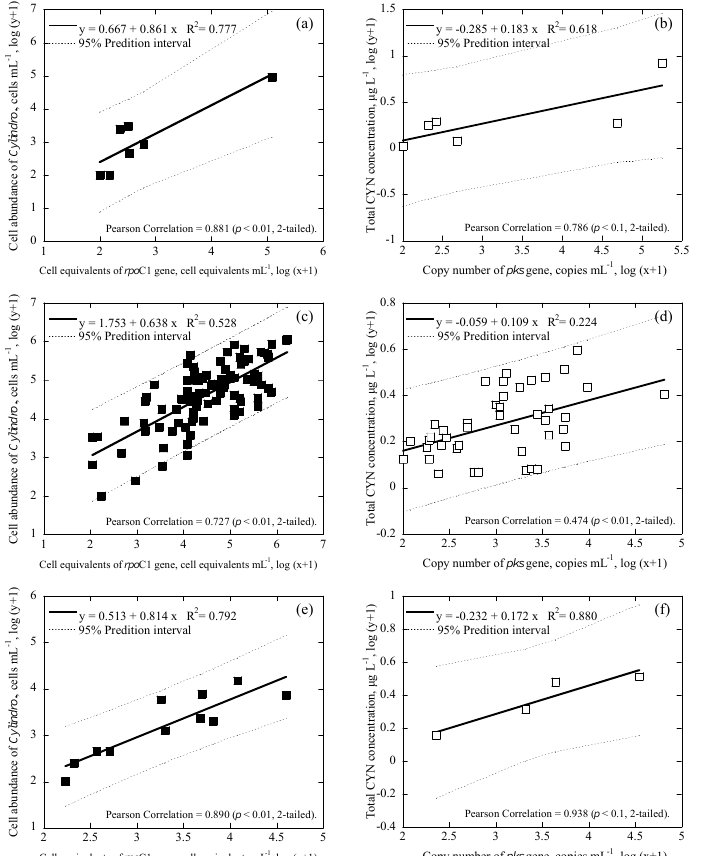
Figure 5. Correlation between cell abundance, toxin concentrations and cell equivalents in the duplex Cylindrospermopsis system with 95% prediction interval (broken line), where (cid:4) represents cell equivalents of rpo C1 gene, represents the copy number of pks gene, ( a ) and ( b ) are for all the data from Taiwan main island (number of samples, n = 7 and 6), ( c ) and ( d ) are for Kinmen islands ( n = 91 and 43), and ( e ) and ( f ) are for Matsu islands ( n = 11 and 4).